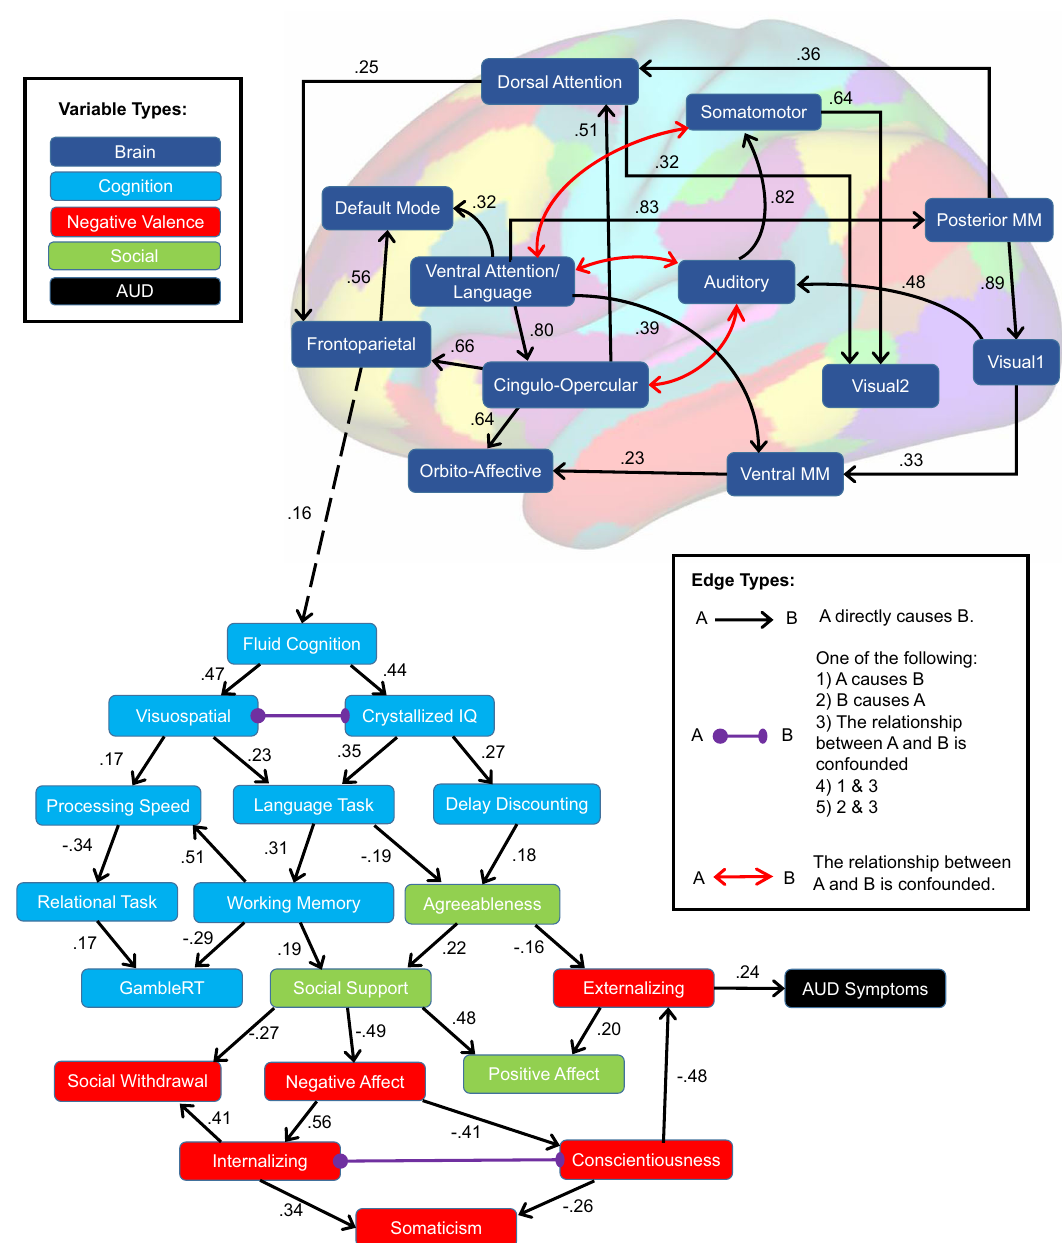
Fig. 1 Causal discovery of the neurobehavioral underpinnings of alcohol use disorder. Causal discovery analysis of the neurobehavioral determinants of AUD symptom severity in the HCP dataset was done using Greedy Fast Causal Inference (GFCI). GFCI returns a partial ancestral graph (PAG) depicting causal relationships between a set of variables, while assessing for unmeasured third variables in relationships (confounders). Standardized edge weights recovered via structural equation modeling (SEM) are displayed in text next to each edge in the graph. The overall SEM fi t was good, RMSEA = 0.06, Tucker-Lewis Index =